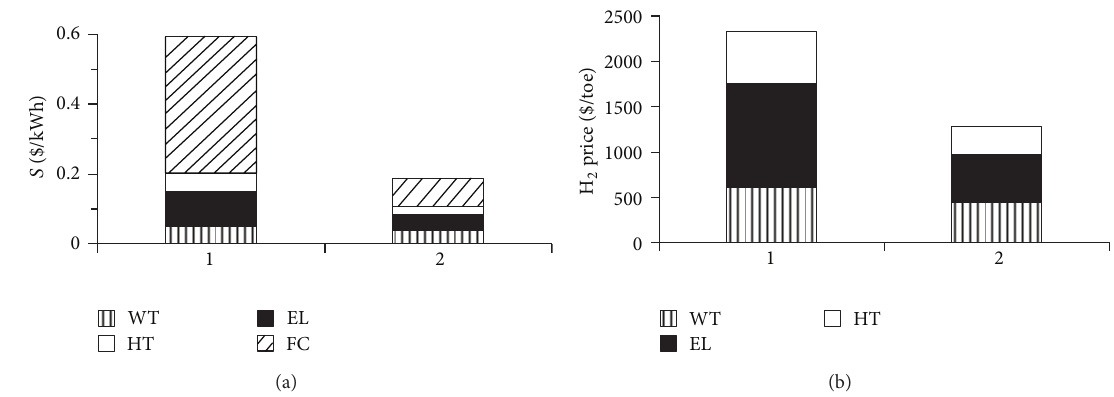
Figure 7: Structure of costs of electricity (a) and hydrogen (b) production at wind speed 6 m/s for the scheme in Figure 2: 1: current indices of the system components; 2: prospective indices. WT are the wind turbines, EL is the electrolyzer; HT is the hydrogen tank, and FC are the fuel